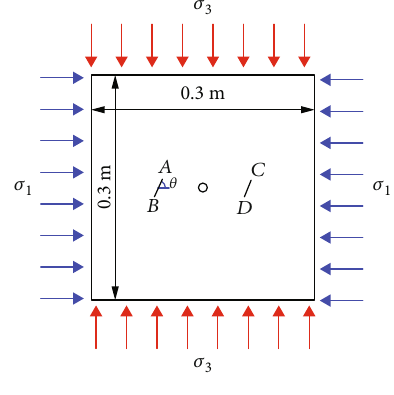
Figure 3: Geometric